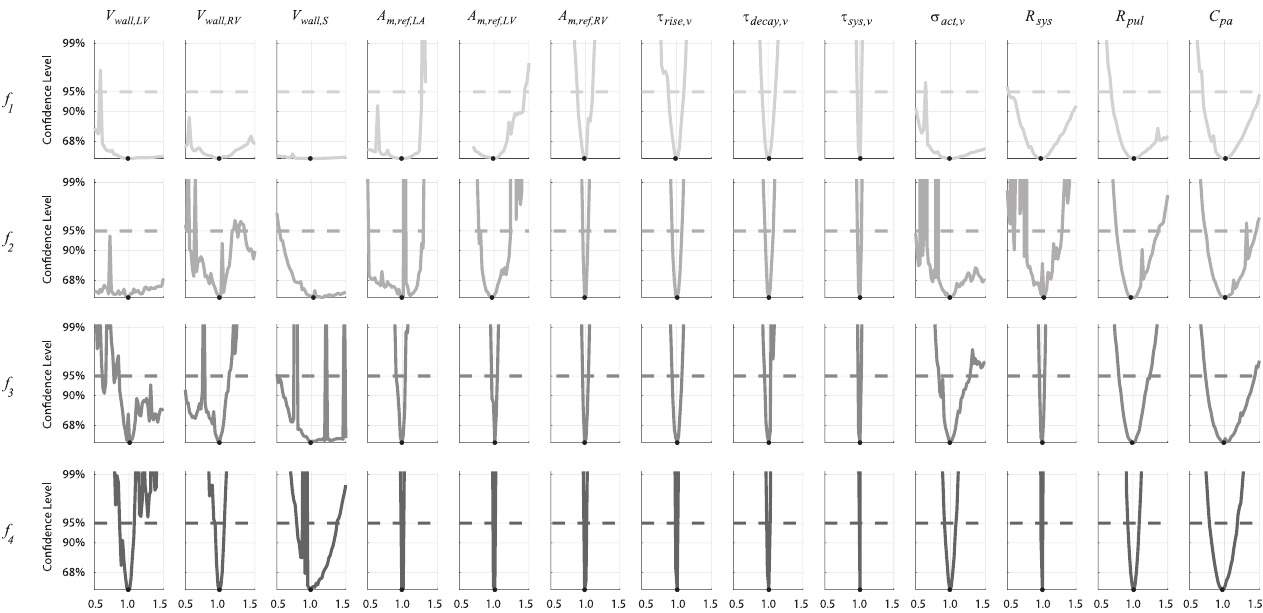
Fig 5. Profile likelihood confidence intervals. Confidence intervals are constructed by fixing one parameter and inferring all others over a range of values. Each row corresponds to a different experimental design. Note that the minimally informative experimental designs ( f 1 and f 2 ) have non-identifiable parameters, indicated by infinite or one-sided confidence bounds. In contrast, inclusion of LV data ( f 3 and f 4 ) remedy the issue of non-identifiable parameters in the set. Large deviations in the profile likelihood correspond to local minima and parameter sets that are incompatible for the system of DAE’s.